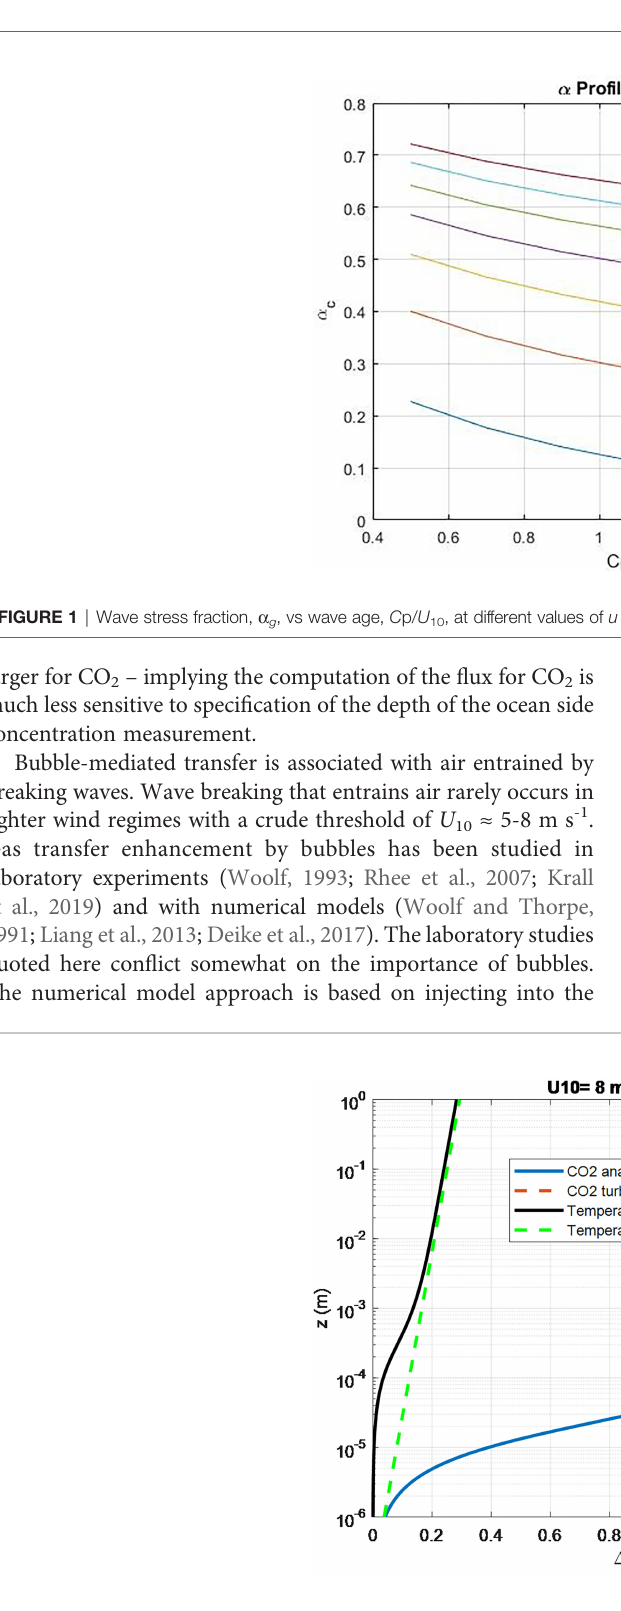
FIGURE 2 | Normalized pro fi les of ocean temperature and CO 2 concentration computed from the analytical solution (solid lines) K ( z ) = k zu * /(1+ d u / z ). The dashed lines are using (21) to represent the turbulent log-layer part of the pro fi